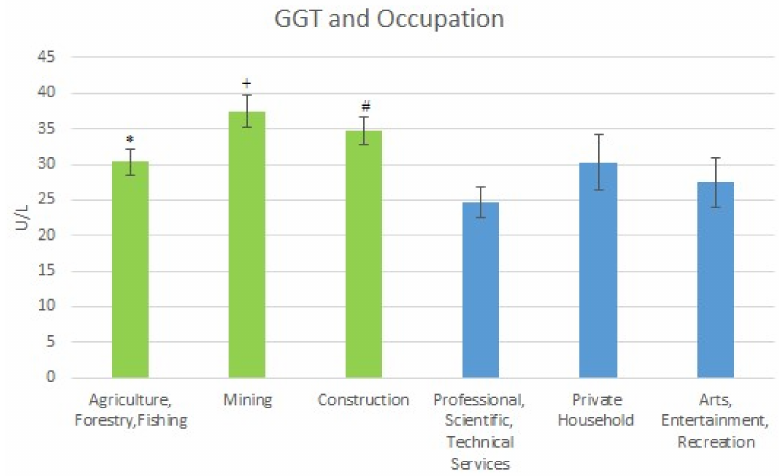
Figure 4. Occupation and Mean GGT Levels. * Significant difference between Agriculture Forestry, Fishing and Professional Scientific, Technical Services. + Significant difference between Mining and Professional Scientific, Technical Services and Arts, Entertainment Recreation. # Significant difference between construction and